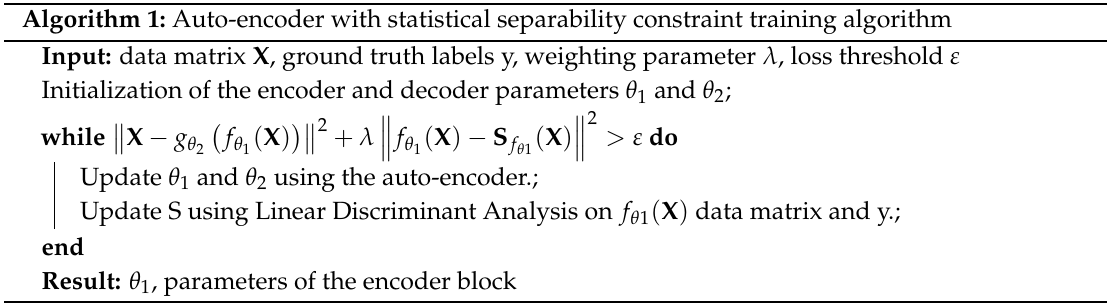
Algorithm 1: Auto-encoder with statistical separability constraint training